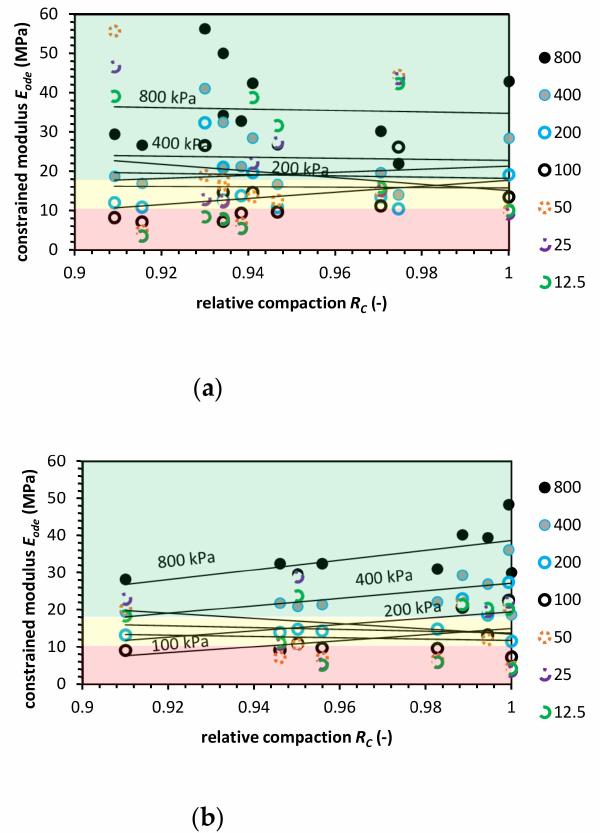
Figure 5. Constrained modulus value versus relative compaction value for recycled concrete ag- gregate (CB) for ( a ) the Proctor compaction and ( b ) the Vibro compaction method. Colored areas mean required constrained modulus value, colors indication: green-zone of fulfilled E ode modulus requirement; yellow-moderate zone, where the constrained modulus is in the range of requirements; red-zone in which the E ode do not meet pipe fill